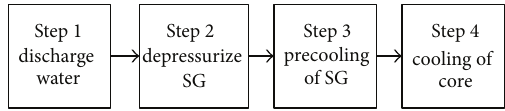
Figure 8: ARHRP with precooling of SG.